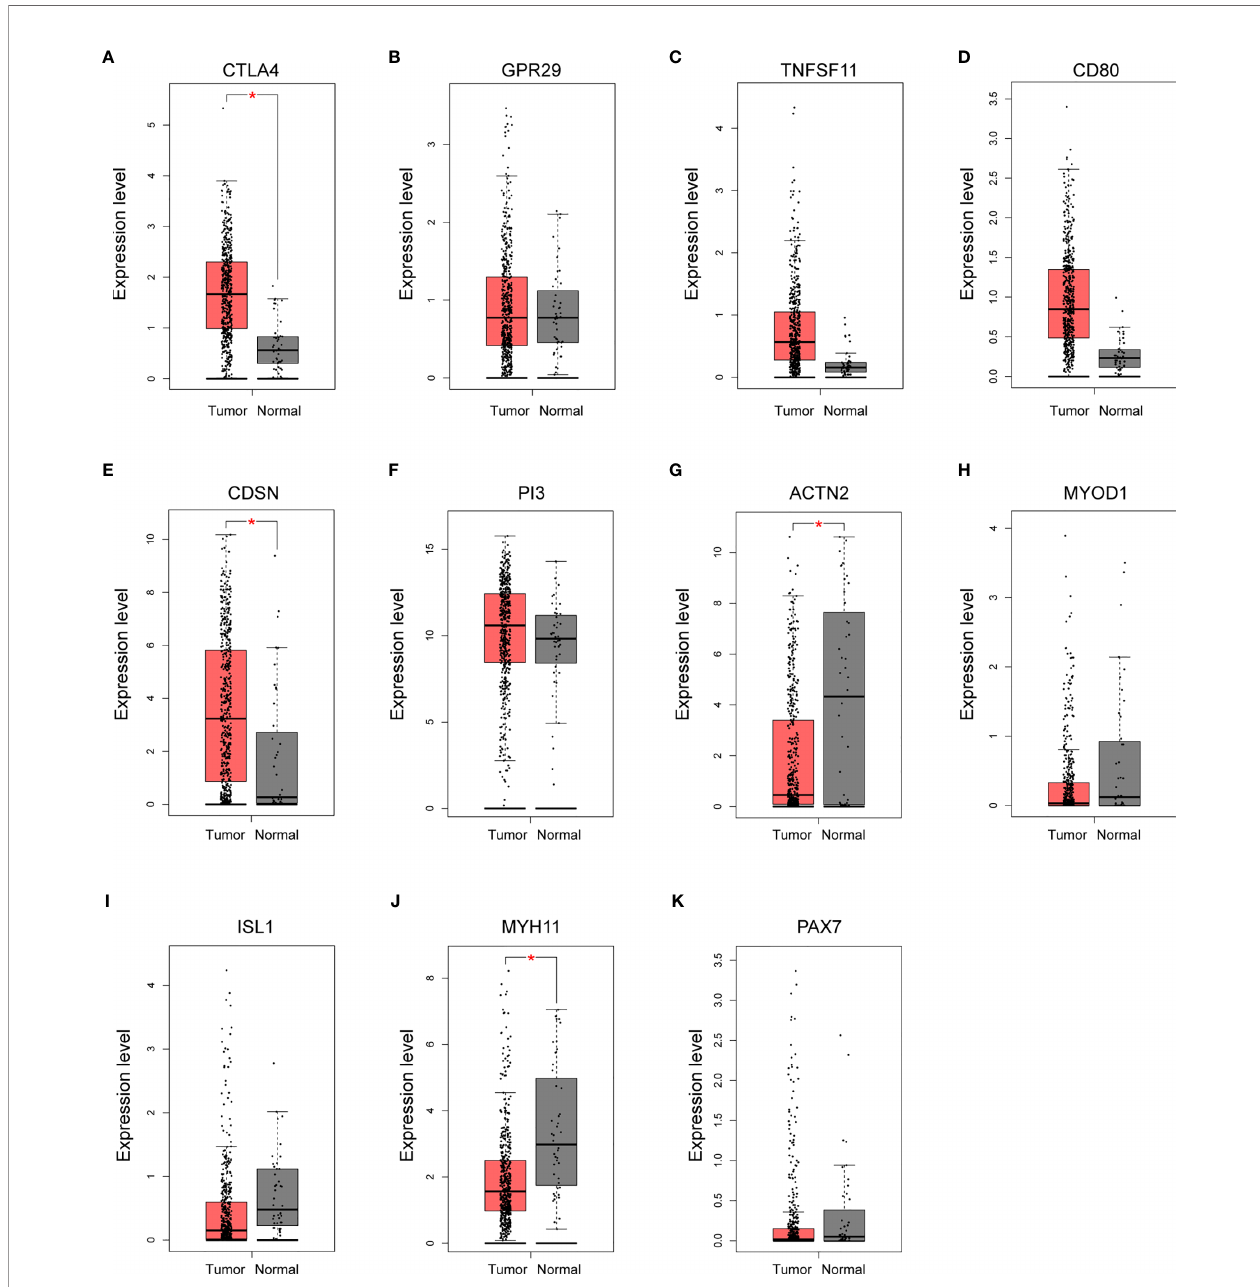
FIGURE 5 | Validation of the expression of potential hub genes in the Cancer Genome Atlas (TGCA) database. (A – K) Box plots showing the relative expression levels of 11 potential hub genes across normal tissues (n = 44) and HNSC tumor samples (n = 519). Expression level indicates log 2 (TPM + 1). TPM, Transcripts Per Million reads. * p <